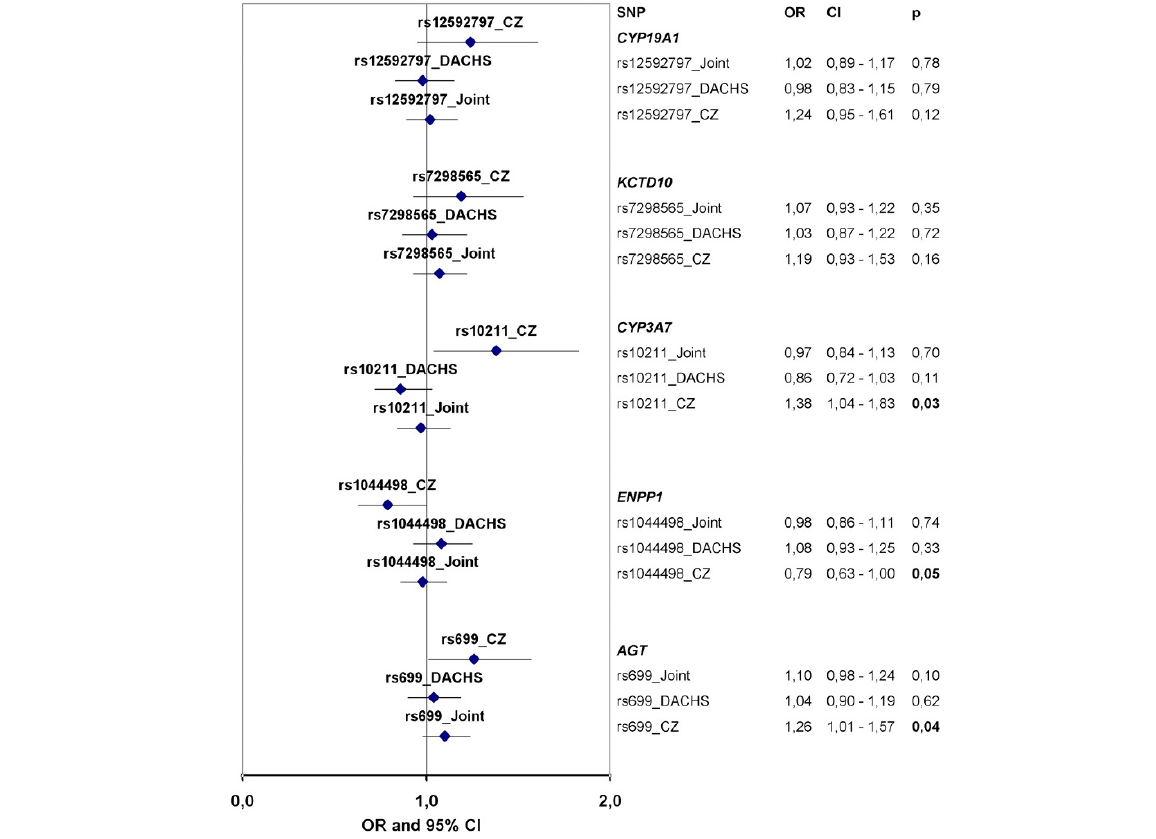
Figure 2 Comparative data plot of the OR and 95% CI of the SNPs analyzed in the Czech and the DACHS cohort; dominant model, individual Czech and DACHS data adjusted for age and sex; joint data adjusted for age and sex, stratified by study; CZ Czech cohort; OR odds ratio; CI confidence